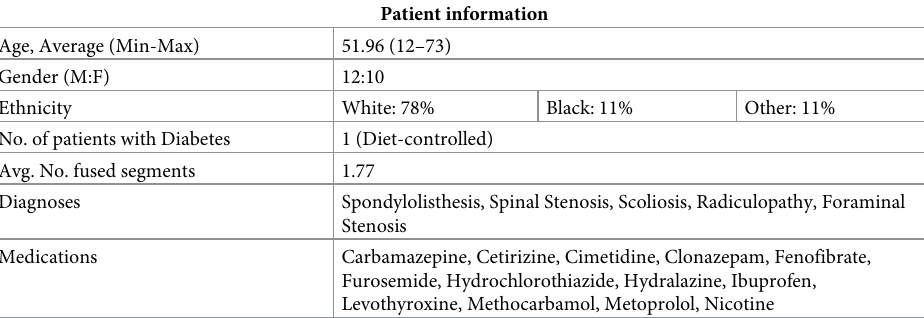
Table 1. Patient